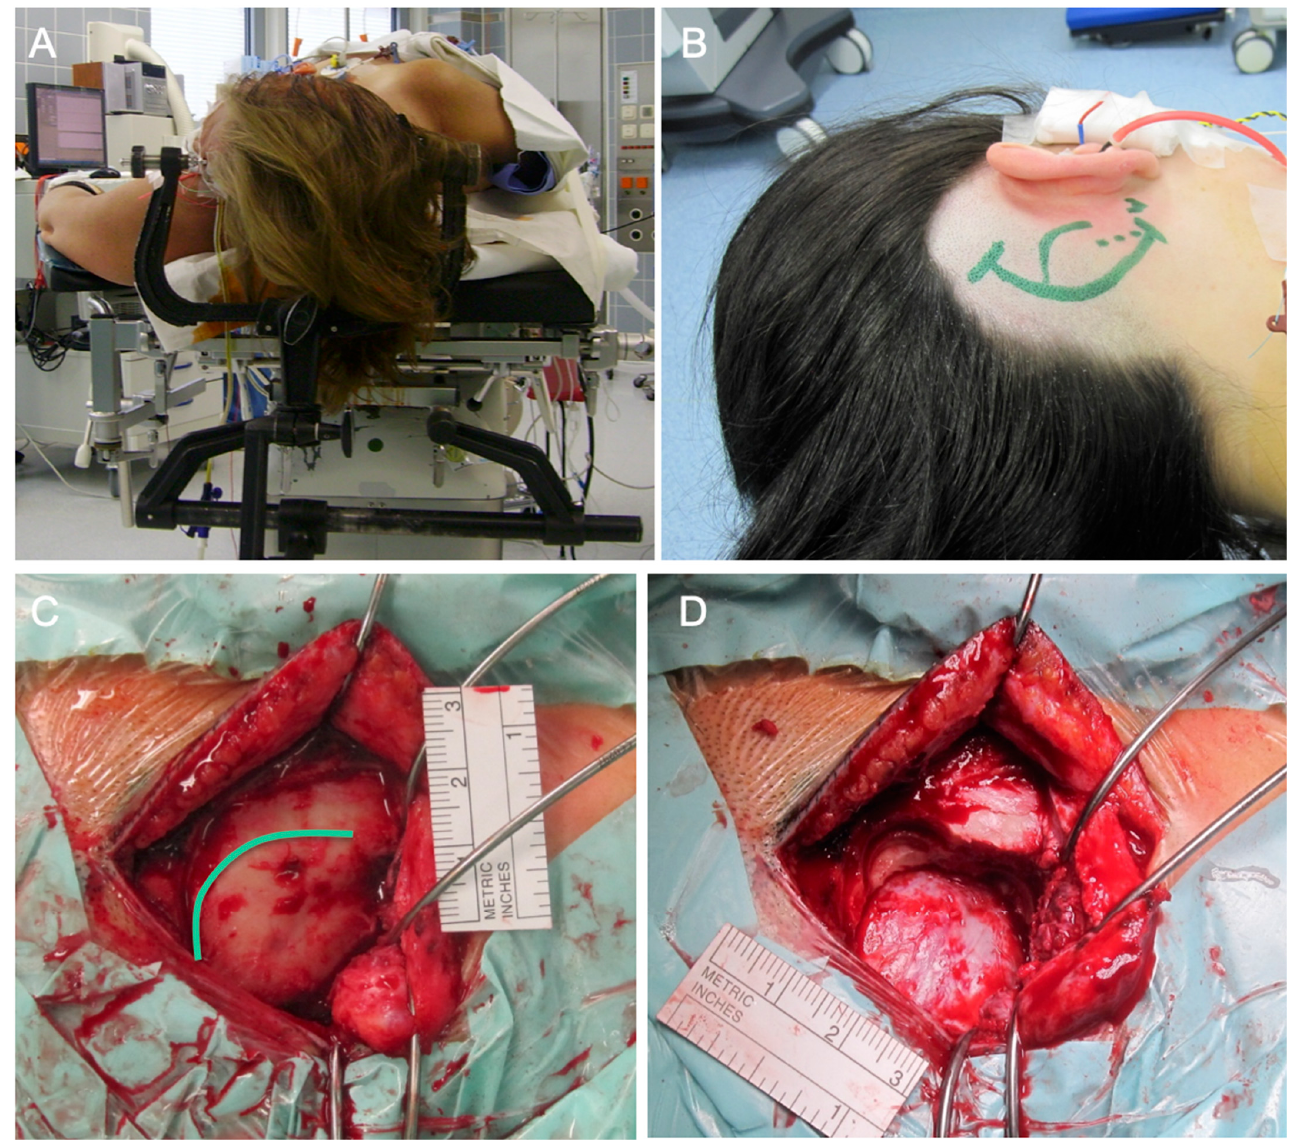
Figure 5. Intraoperative illustration of a retrosigmoid osteoclastic craniotomy. ( A , B ) The patient is placed in a supine position. The head should be rotated as much as possible (90°) while utilizing a large shoulder roll underneath the ipsilateral shoulder. A classic retroauricular curvilinear incision is performed. ( C ) Identification of the transverse-sigmoid junction will guide placement of a burr hole just below this junction. The burr hole is created where the transverse sinus (imaginary connection of inion with the root of the zygoma) crosses the sigmoid sinus at the level of the mastoid groove (green line). The asterion is not a constant finding and a burr hole over the asterion often exposes the entire width of the transverse sinus, placing this structure at risk. ( D ) The exact location of these dural sinuses is slightly variable and the initial burr hole should be placed with caution; it may be enlarged with further burr holes in the correct direction when the initial small pilot burr hole is done. The craniotomy may be continued by further osteoclastic enlargement with a rongeur or a handheld drill. Air cells are waxed to prevent development of a postoperative cerebrospinal fluid fistula.